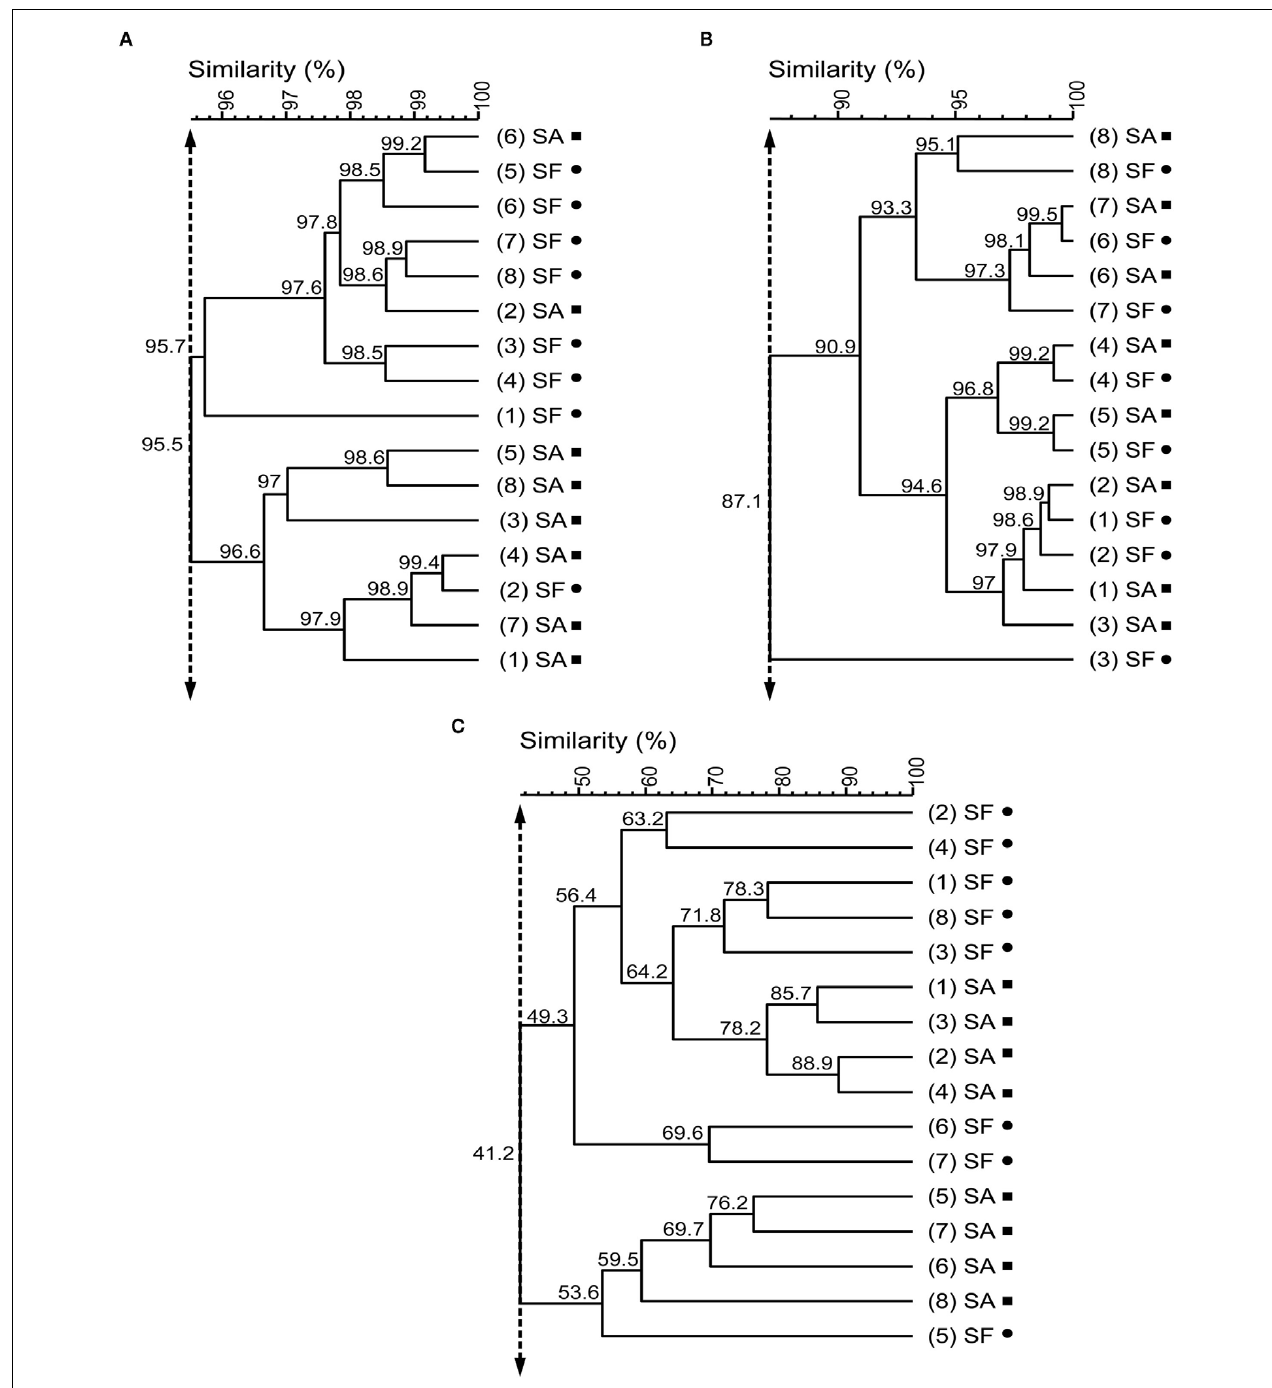
FIGURE 2 | Unweighted pair group method with average linkages dendrograms of bacterial communities associated with S. angustifolium (SA, squares) and S. fallax (SF, circles). The dendrograms were generated from the PCR-SSCP profiles of Bacteria (A) ,